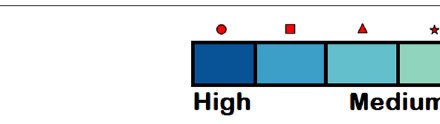
Fig. 6 Heatmaps scale based on weights